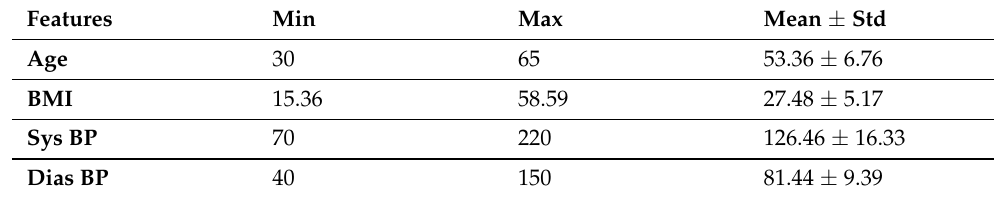
Table 3. Statistical characteristics in the balanced data.